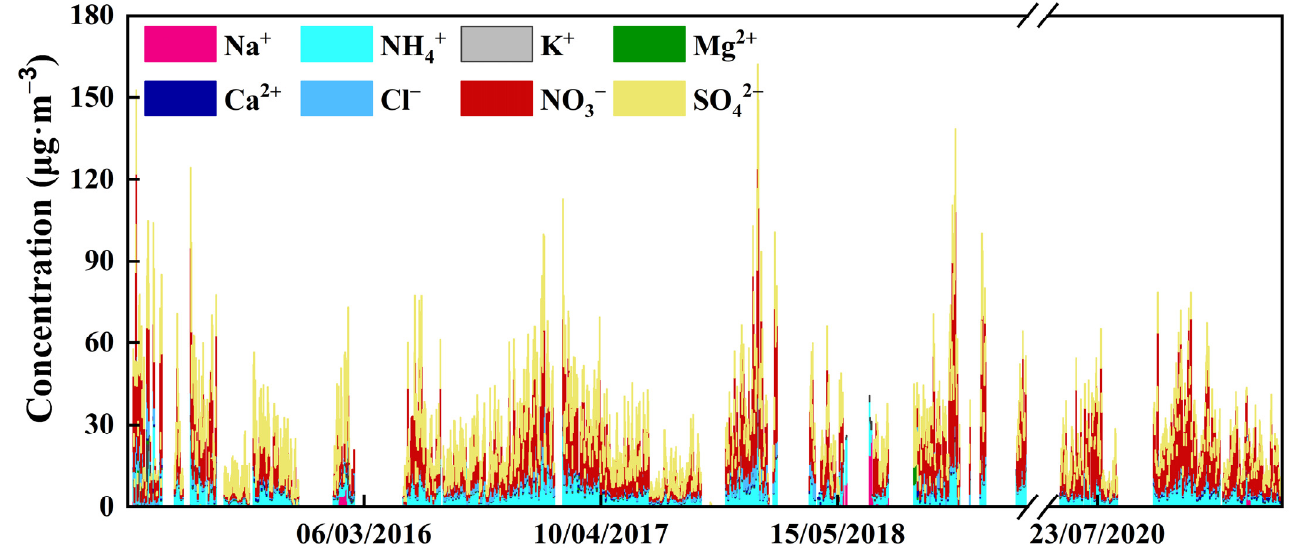
Figure 2. Time-series of daily water-soluble inorganic ions in PM 2.5 . Table 1. Statistical summary of the daily average concentrations ( μ g·m − 3 ) of WSIIs.